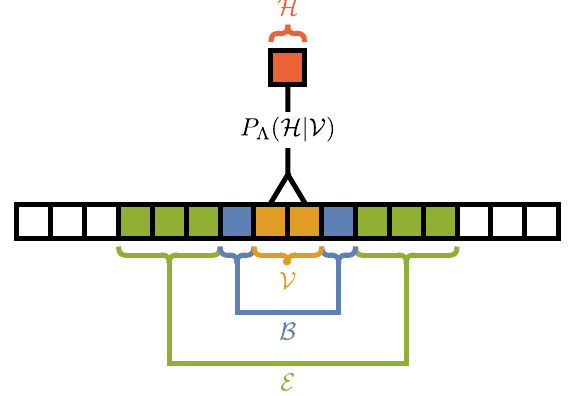
FIG. 2. Schematic decomposition of the system for the purpose of defining the mutual information I Λ ð H ∶ E Þ (in 1D, for con- creteness). The full system is partitioned into blocks of visibles V (yellow) embedded into a buffer B (blue) and surrounded by the environment E (green). The remaining part of the system is denoted by O in the main text. The conditional probability distribution P Λ ð H j V Þ couples V to the hiddens H